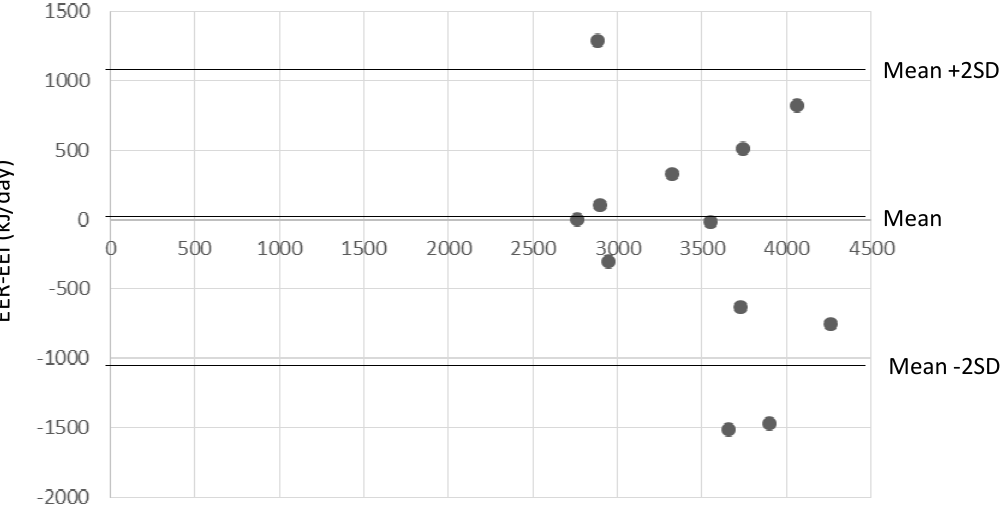
Figure 1. The difference between estimated energy requirement (EER) and estimated energy intake (EEI), plotted against the mean of EER and EEI ( n = 12). SD = Standard